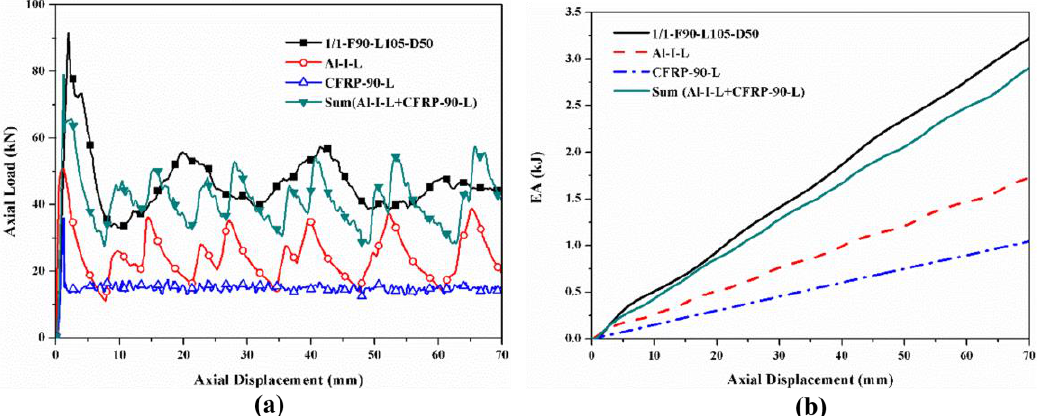
Figure 18. Hybrid effect of 1/1 hybrid tube with nominal outer diameter of 50 mm: ( a ) axial load – displacement curves; ( b ) EA – displacement curves.